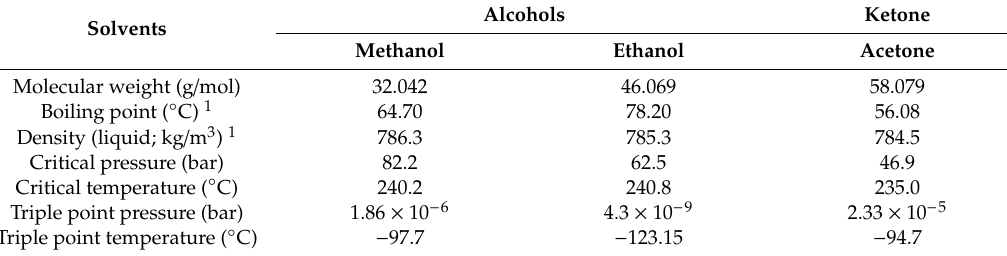
Table 2. Properties of solvents, i.e., two alcohols and one ketone, used in the